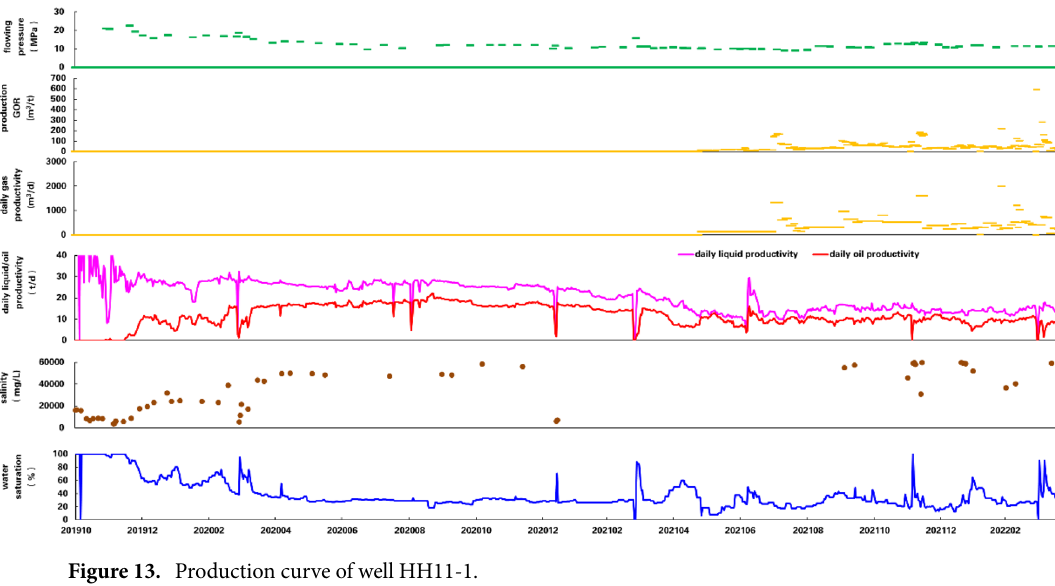
Figure 13. Production curve of well